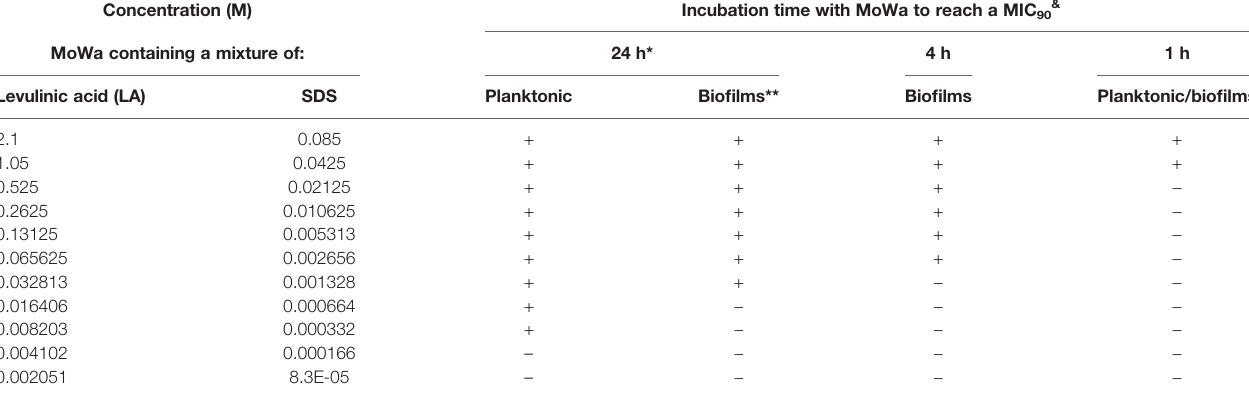
TABLE 2 | Antibacterial effect of MoWa (LA+SDS) against MRSA strain NRS38. Concentration (M) Incubation time with MoWa to reach a MIC 90& MoWa containing a mixture of: